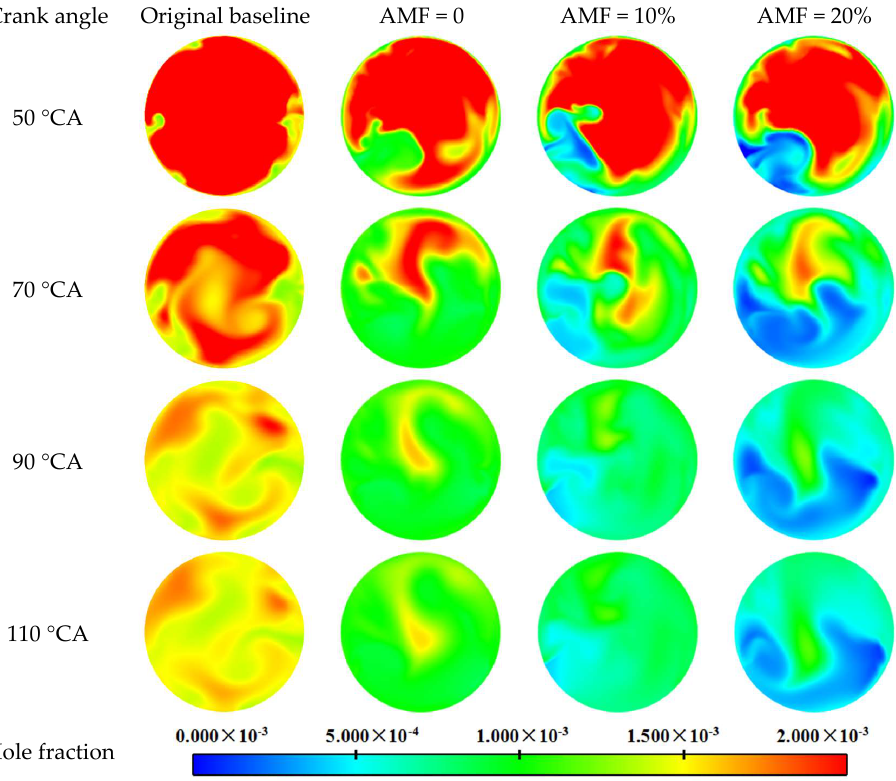
Figure 9. NO evolution with variation of AMF (DI timing = −105 °CA).